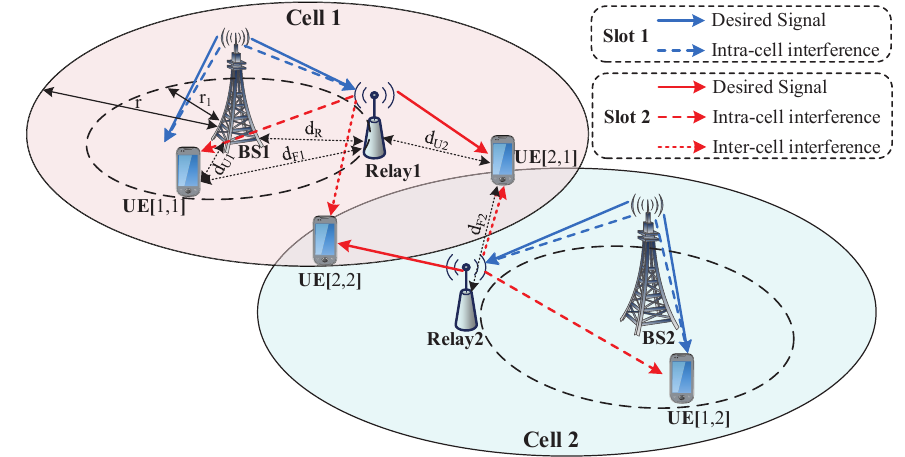
Figure 1. System model of two-cell relay heterogeneous network